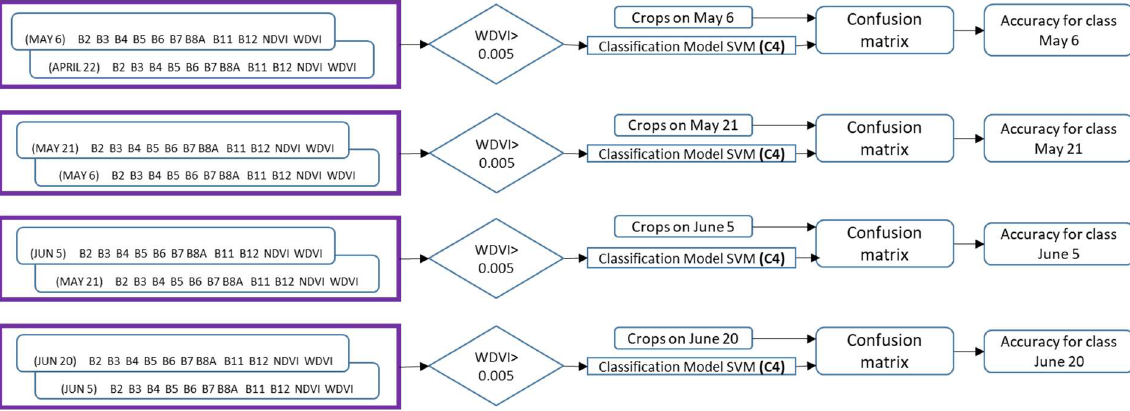
Figure 2. Steps followed in the validation on the next crop cycle using the SVM classification model on different dates only with combination 4 (C4).